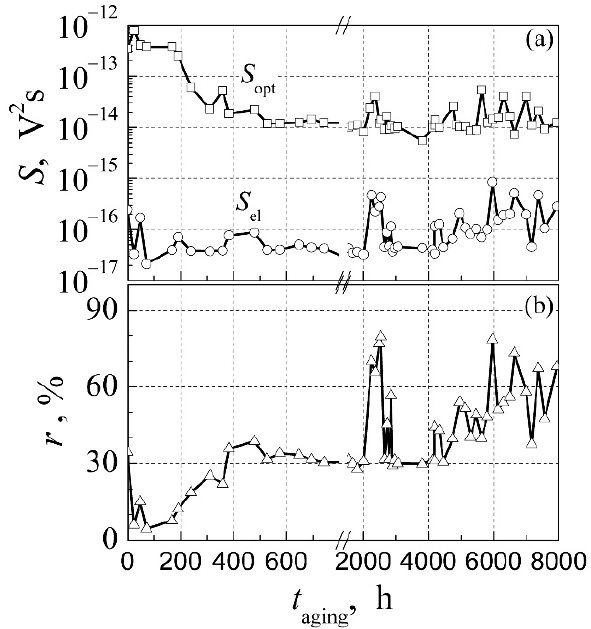
Figure 11. Dependences of ( a ) the electrical and optical noise spectral densities (at 280 Hz frequency) and ( b ) the simultaneous cross-correlation coefficient between optical and electrical fluctuations (in frequency range 10 Hz–20 kHz) on the aging time measured at forward 30 mA current. Reprinted with permission from [26].